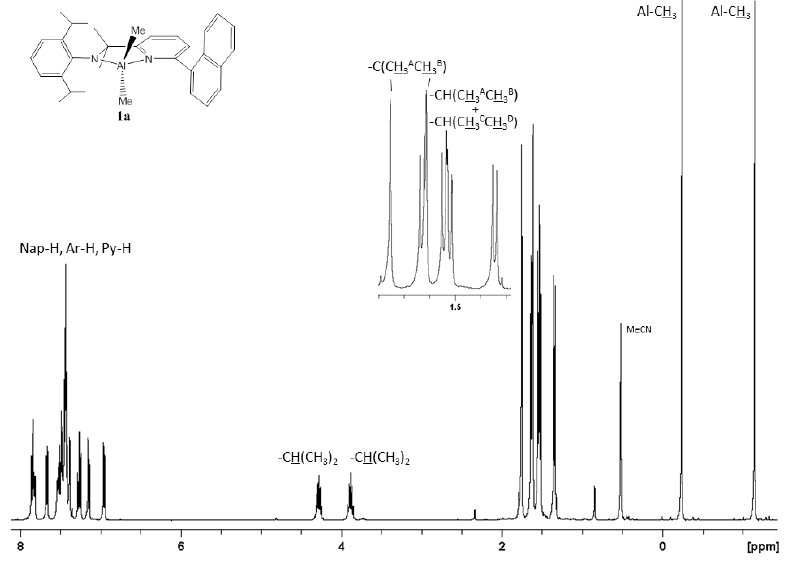
Figure 4. 1 H NMR (400 MHz) spectrum of 1a in C 6 D 6 at room